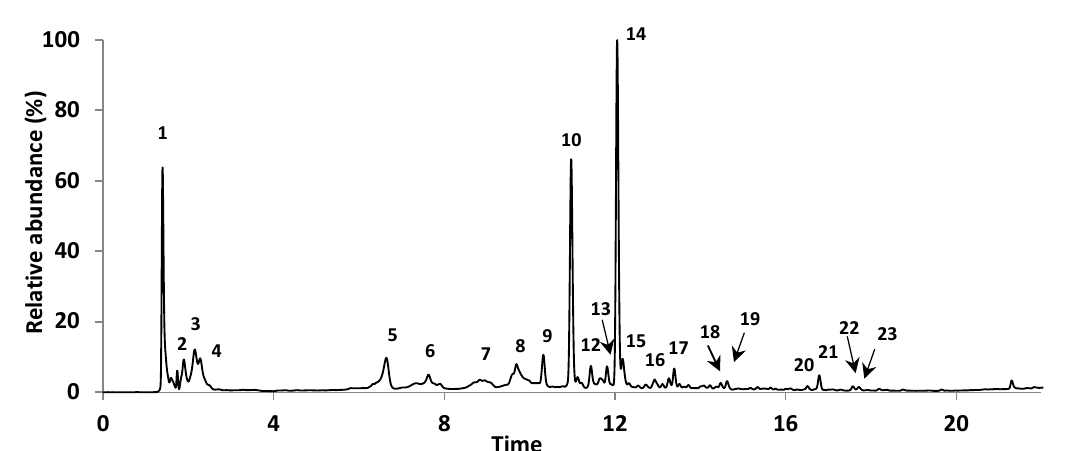
Figure 3. Chromatographic profile at 280 nm of M. communis pericarp extract obtained by UAE extraction at optimized conditions. Numbers in the figure correspond to the eluted UHPLC peaks for which UV and MS data are summarized in Table 4.